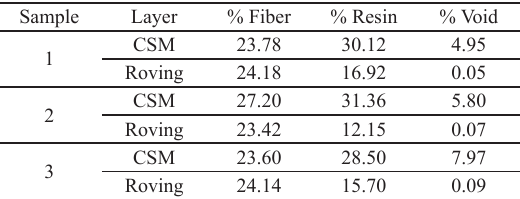
Table 7. Phase’s content (in volume) in CSM and roving layer for the